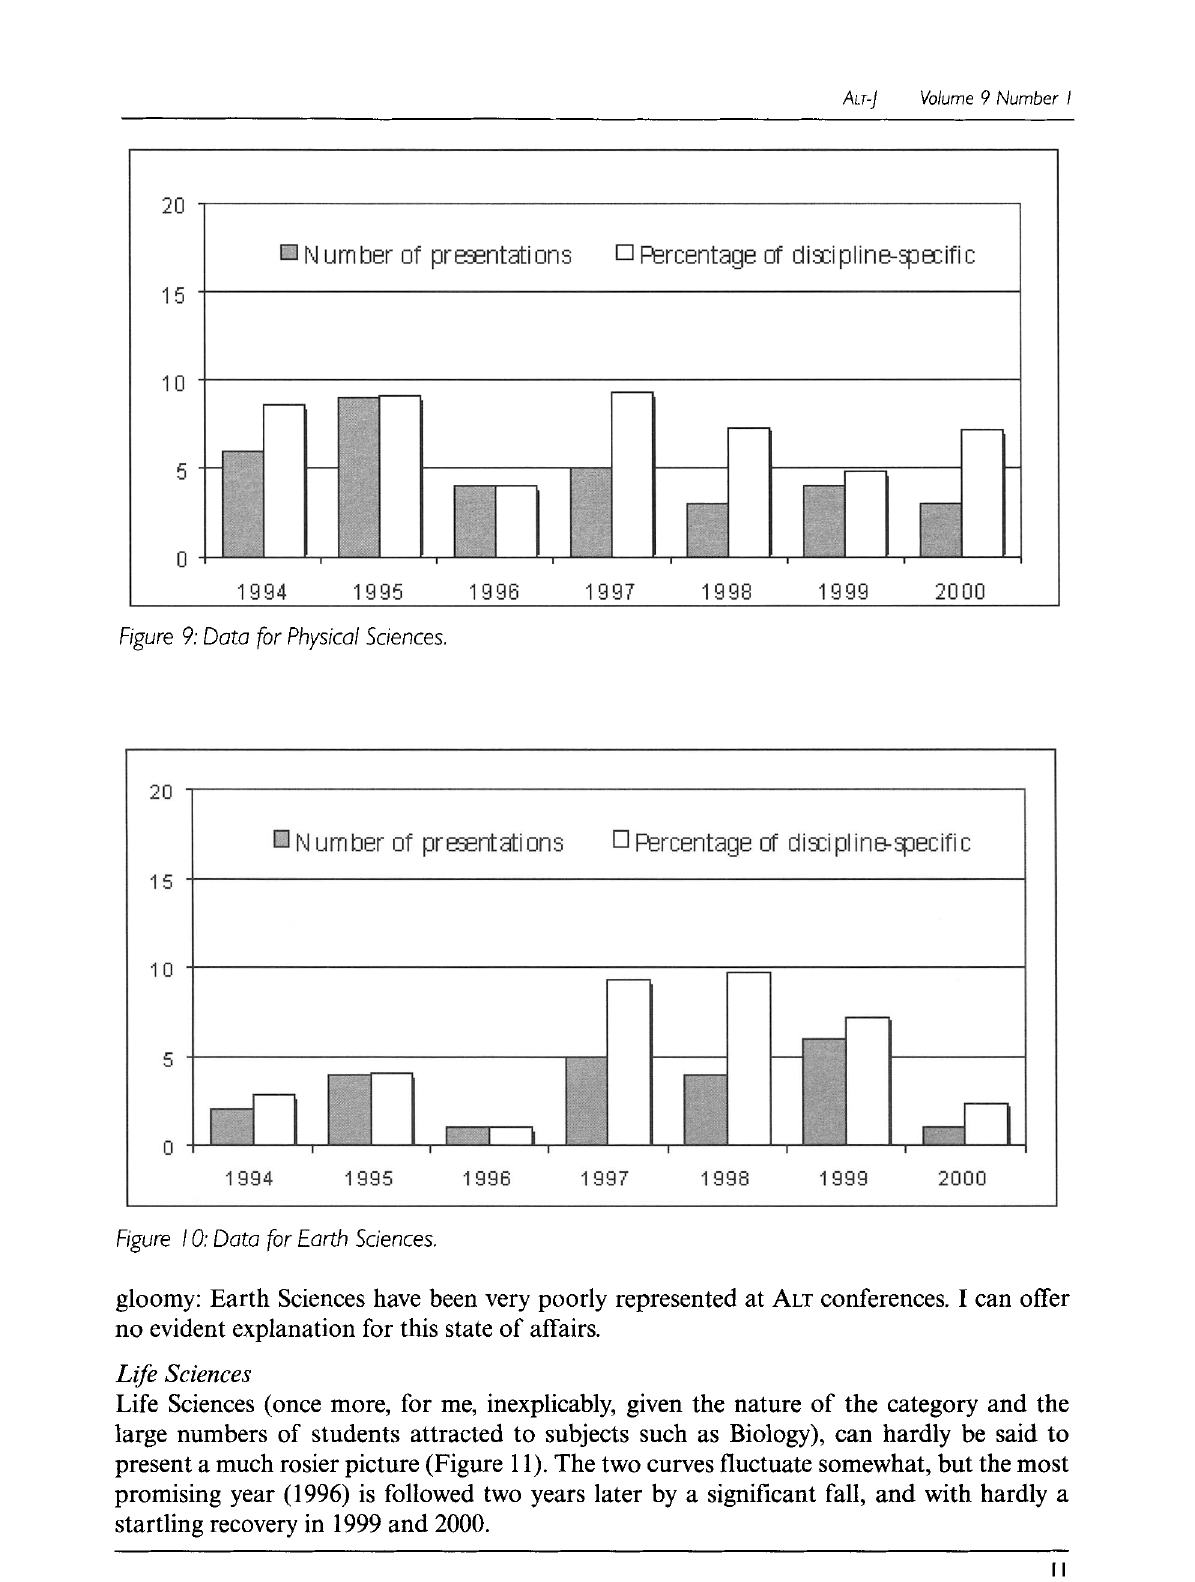
Figure I O: Data for Forth